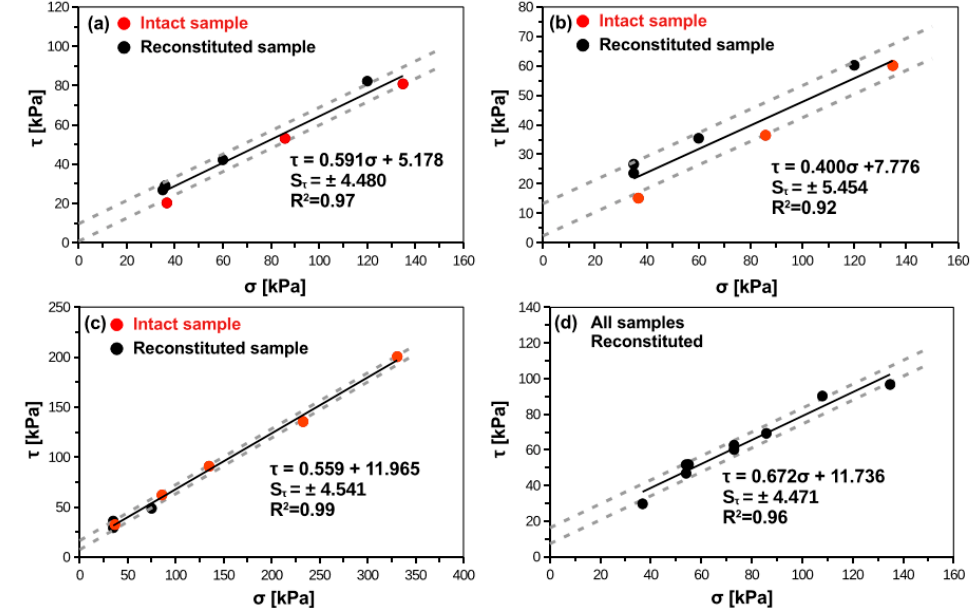
Figure 5. Mohr-Coulomb failure envelope of rough concrete–soil interface for ( a ) silty loam, ( b ) organic clay, ( c ) peat, ( d ) organic silt.